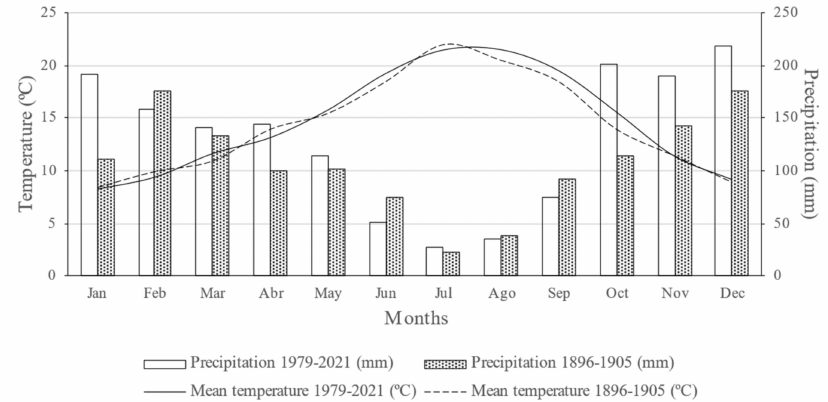
Figure 9. Overlay of climate data for the period of 1979–2021 and climate data for the period of 1896–1905.